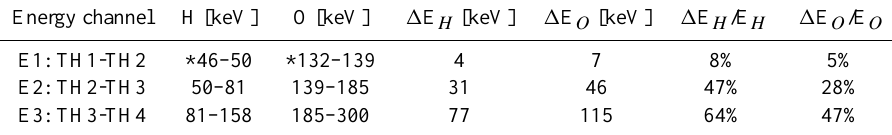
Table 2. Energy bands for NUADU.